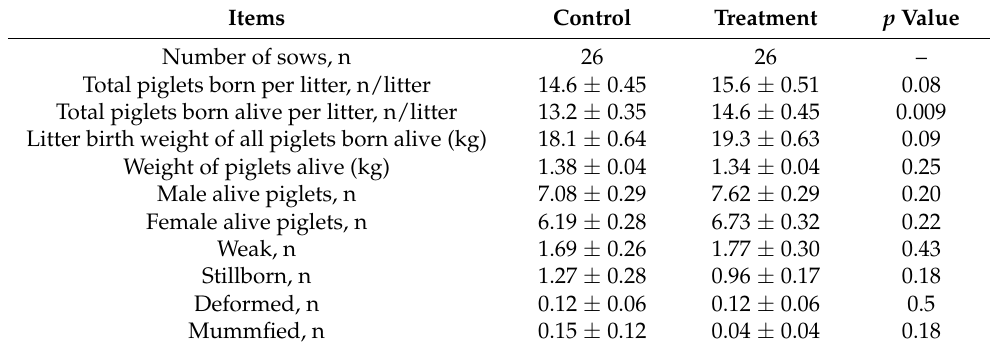
Table 4. Effects of medium- and short-chain fatty acids on the reproductive performance of sows 1,2 . Items Control